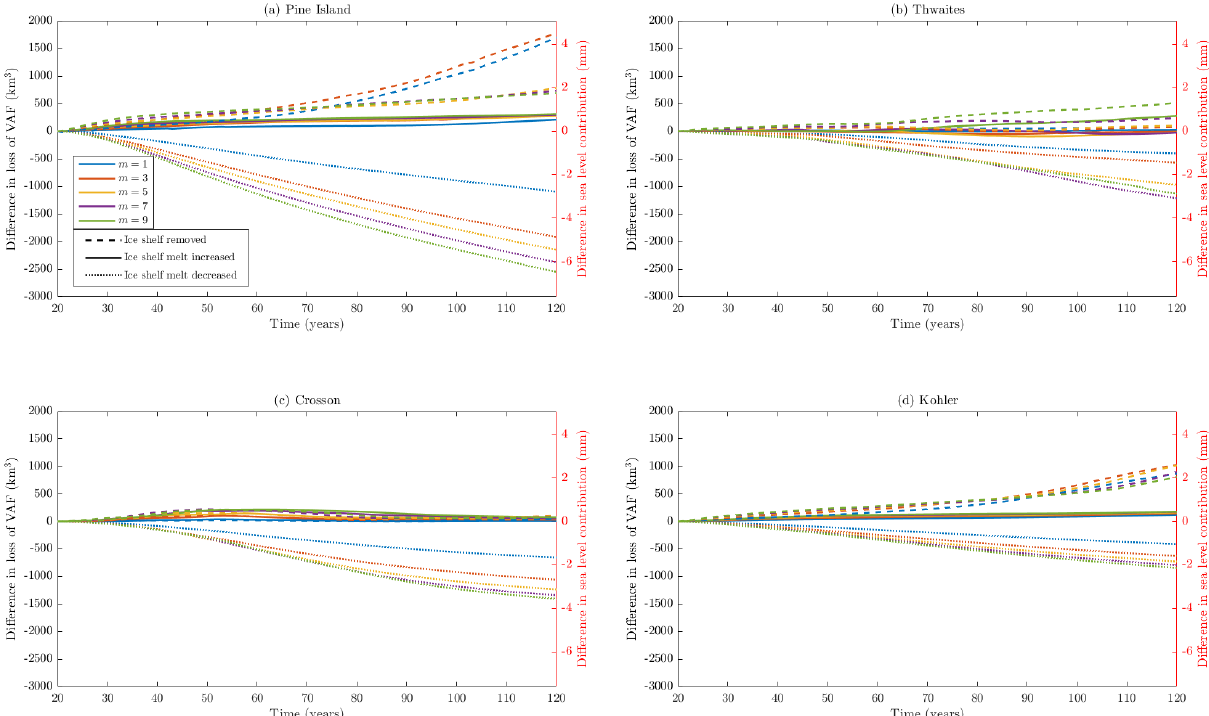
Figure 6. Magnitudes of additional VAF loss compared to the control branch for the Weertman sliding law with different values of m . The contributions of each region within the ASE domain are